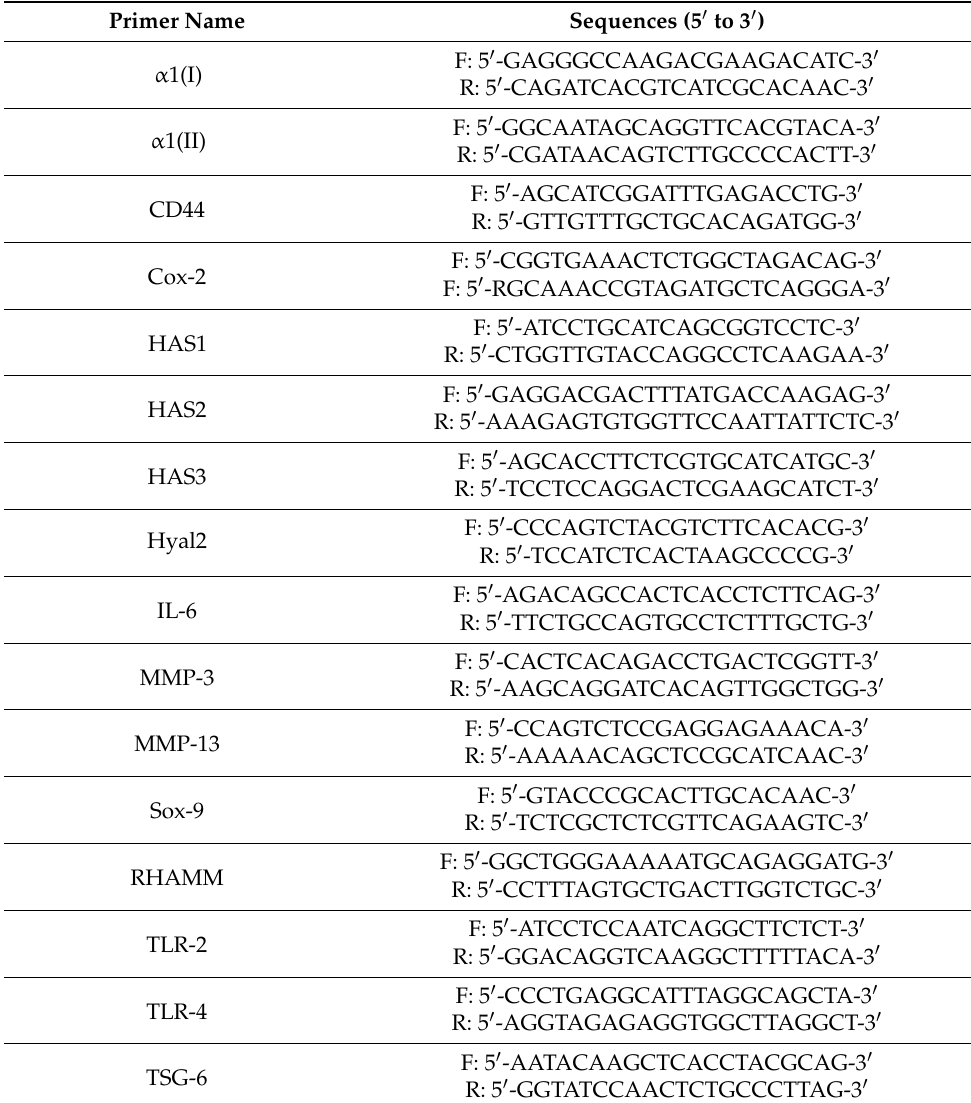
Table 1. The sequences of the primers used for real-time